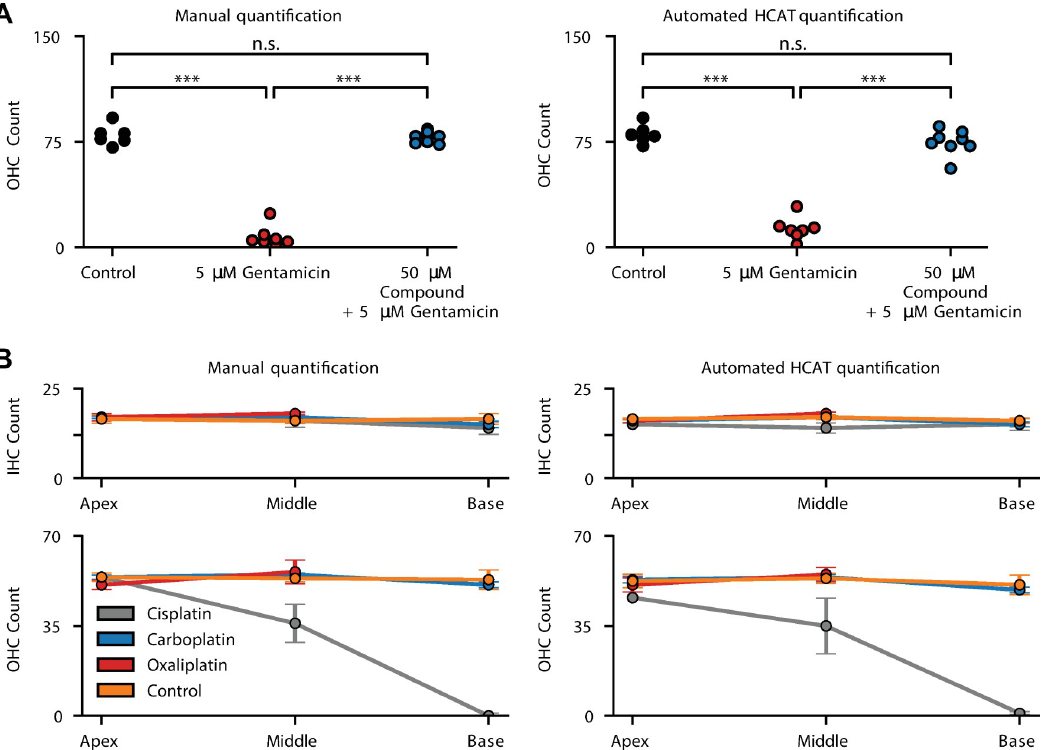
Fig 6. Evaluation of HCAT performance on cochlear datasets to assess ototoxic drug effect. To assess HCAT performance on aberrated cochlear samples, we compared HCAT analysis results to manual quantification on datasets from two different publications focused on assessing hair cell survival following treatment with ototoxic compounds. (A) Original imaging data of P3 CD1 mouse cochlea, underlying the finding in Fig 2F of Kenyon and colleagues, 2021 [7], generously provided by the Richardson and Kros laboratories. Images were collected using epifluorescence microscopy, following a 48-h incubation in either 0 μ m gentamicin (Control), 5 μ m gentamicin, or 5 μ m gentamicin + 50 μ m test compound UoS-7692. Each symbol represents the number of OHCs in a mid-basal region from 1 early postnatal in vitro cultured cochlea [7]. One-way ANOVA with Tukey’s multiple comparison tests. *** , p < 0.001; ns , not significant. In some cases, HCAT detections overestimated the total number of surviving hair cells in the gentamycin-treated tissue. However, overall, the software-generated results are in agreement with those of the original study, drawing the same conclusion. (B) Original imaging data of adult mouse cochleae, underlying the finding in Fig 7A-B in Gersten and colleagues, 2020 [31] were generously provided by the Cunningham laboratory. In this study, mice were treated by in vivo application of clinically proportional levels of ototoxic compounds, Cisplatin, Carboplatin, Oxaliplatin, and Saline (control), in an intraperitoneally cyclic delivery protocol [31]. Regions of interest were imaged at the base, middle, and apex of each cochlea. HCAT’s automated detections were comparable to manual quantification and were sufficient to draw a conclusion that is consistent with the original publication. Upon comparison, HCAT had higher detection accuracy in OHCs, compared to IHCs, likely due to the variability of the MYO7A fluorescence intensity levels in IHCs across the dataset. HCAT, hair cell analysis toolbox; IHC, inner hair cell; OHC, outer hair